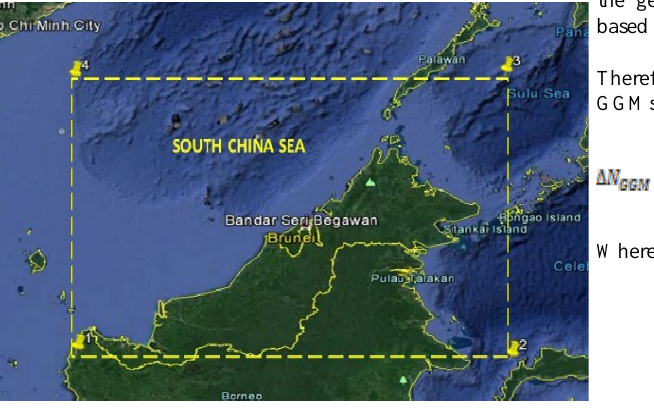
Figure 2. The map of the study area